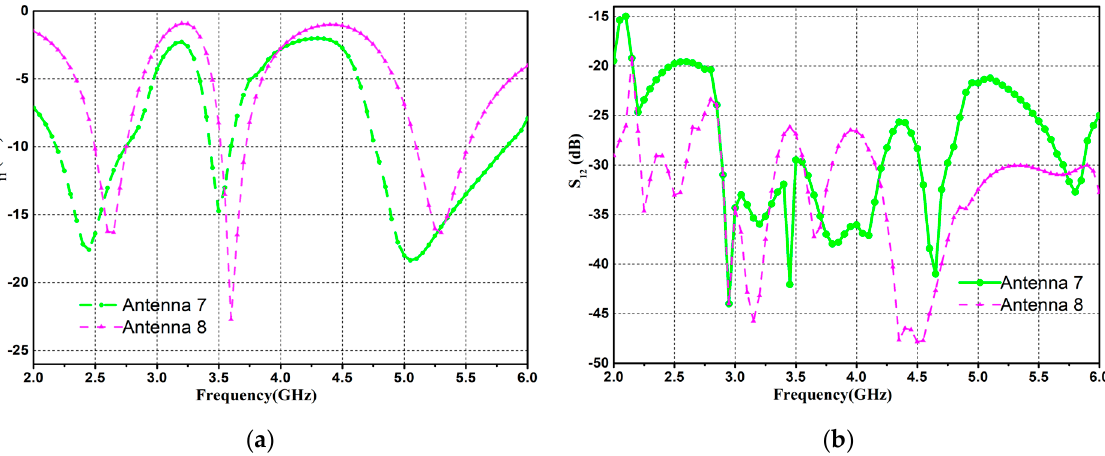
Figure 5. Scattering parameters (reflection and transmission) of the MIMO antenna design stages: ( a ) S 11 ; ( b ) S 12 .